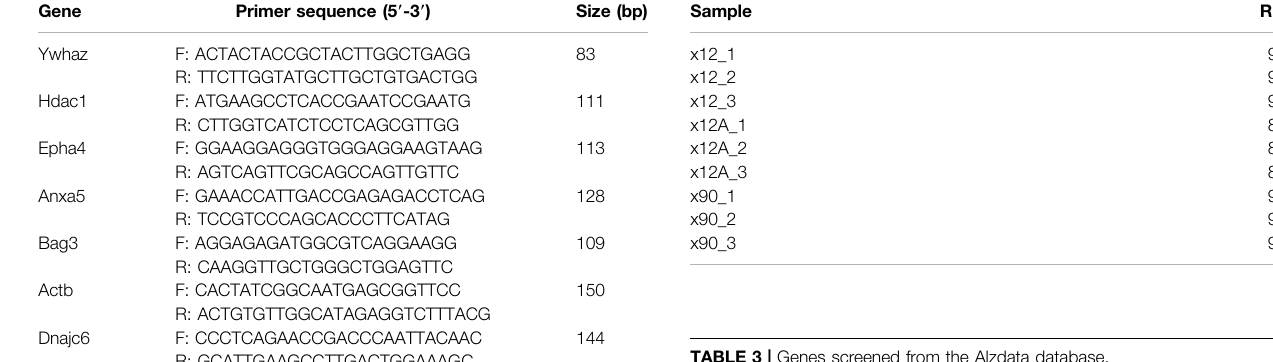
TABLE 3 | Genes screened from the Alzdata